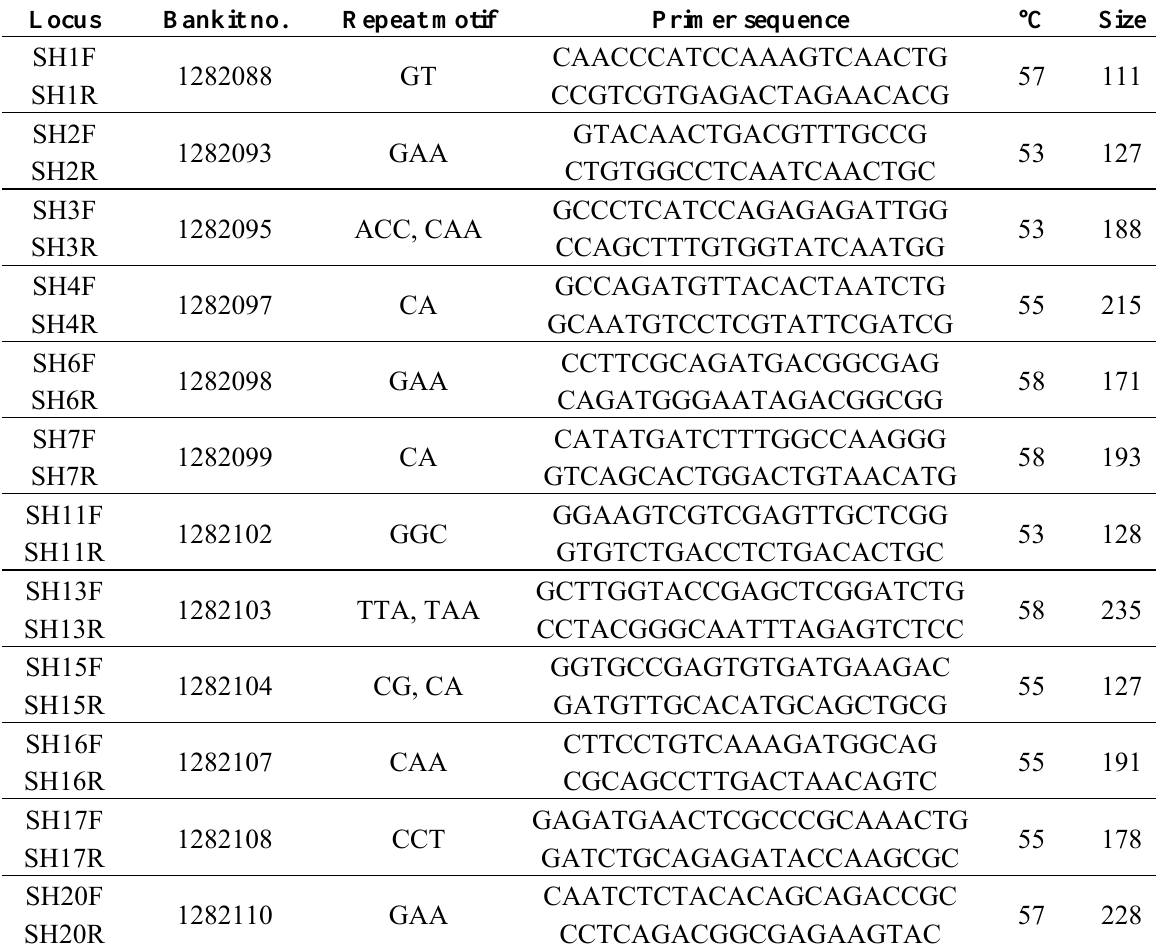
Table 1. Microsatellite loci optimized for leafy seadragons. Columns from left to right are: the locus and name of each primer; Bankit number from the Genbank for each locus; the repeat motif found in each locus; the primer sequence for the forward and reverse primers; the optimized temperatures for PCR amplification (see text); and the estimated size of each amplified